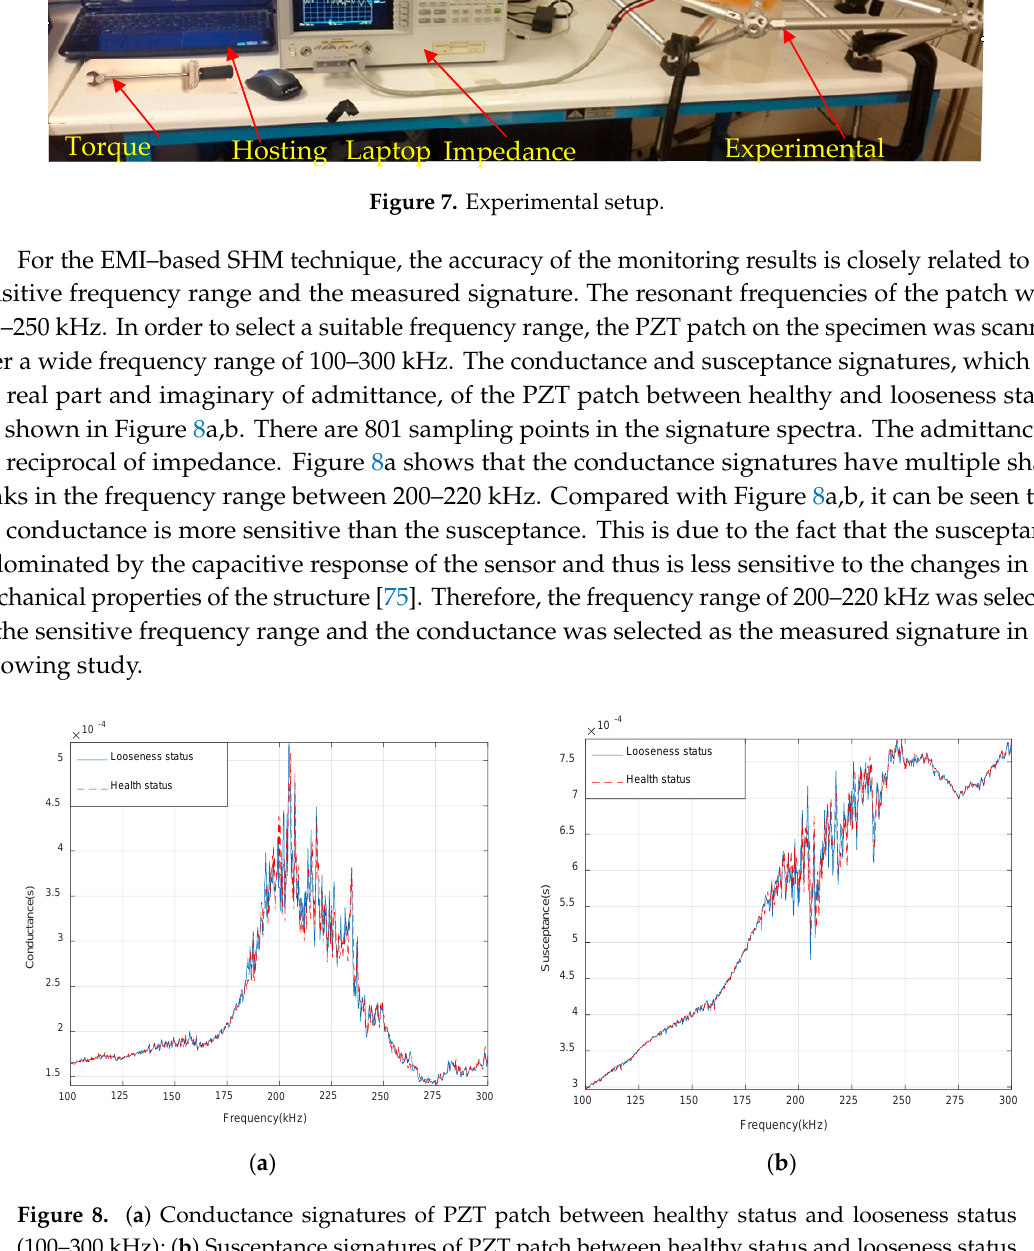
Figure 6. Detailed dimension of the location of PZT patch (unit: mm).